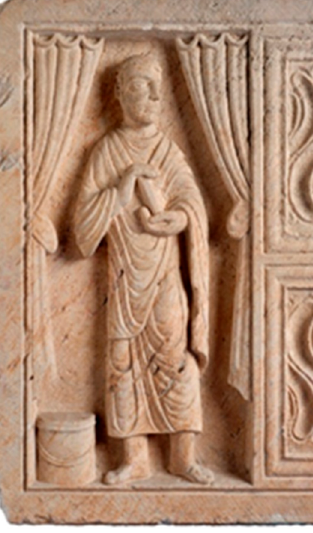
Figure 19. Mosaic of Sant’Apollinare in Classe, Ravenna (Italy). Sixth century. Abraham, Abel, and Melchisedec © Author: Sailko.